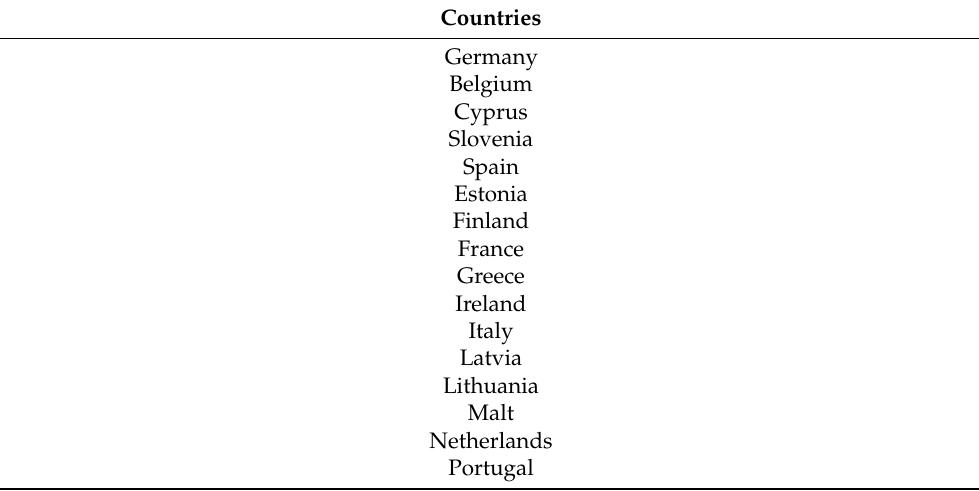
Figure 1. Summary of the applied methodology. Table 2. DMUs